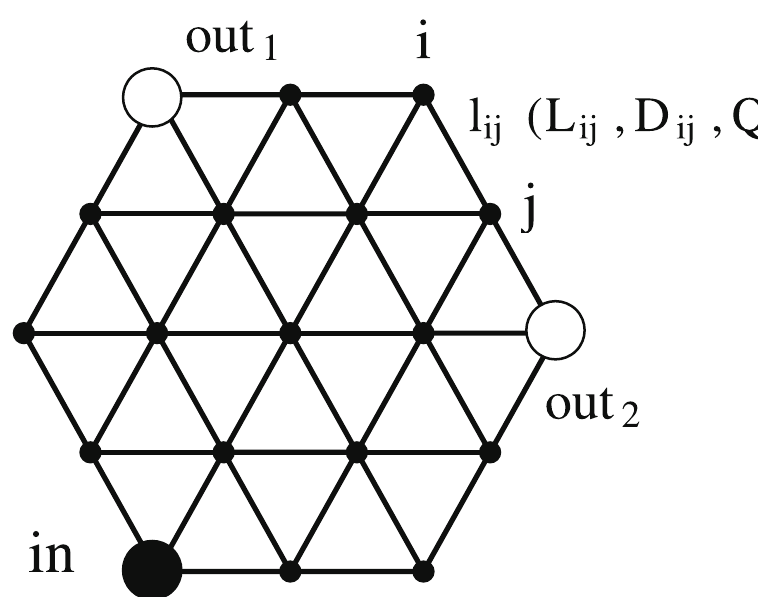
Figure 1. Network topology used by the Physarum algorithm for numerical calculation.